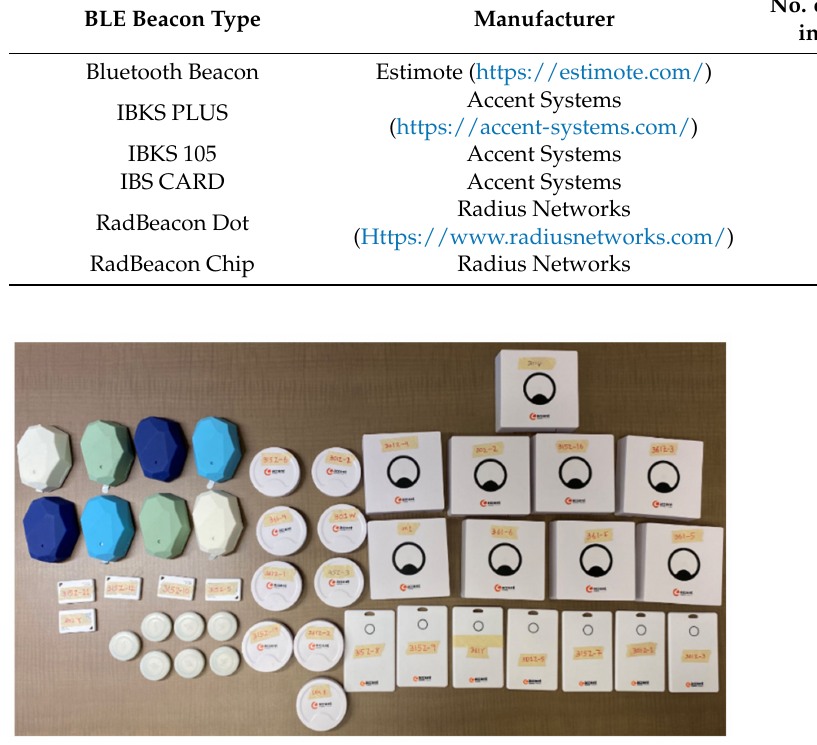
Figure 10. Six different types of BLE beacons from three different BLE manufacturers used in real-world